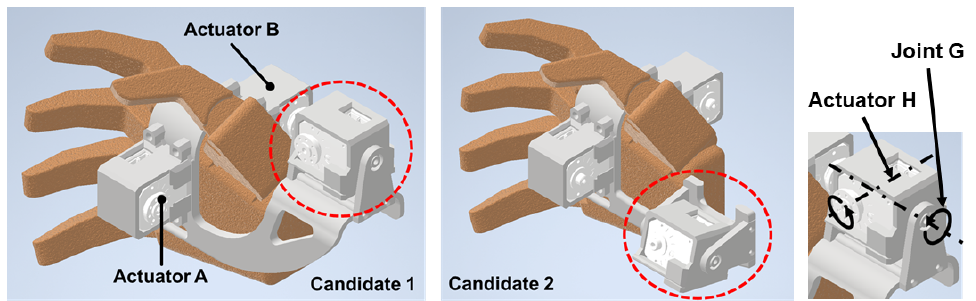
Figure 9. CAD images of two candidates, with the different placements of joints G and H: candidate 1 designed to be located behind the thumb, and the candidate 2 designed to be located beside the wrist.